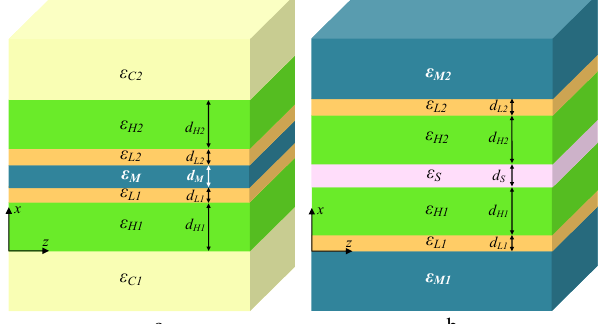
Figure 1: Geometries of hybrid plasmonic slab waveguides: a. hybrid insulator–metal–insulator, and b. hybrid metal–insulator–